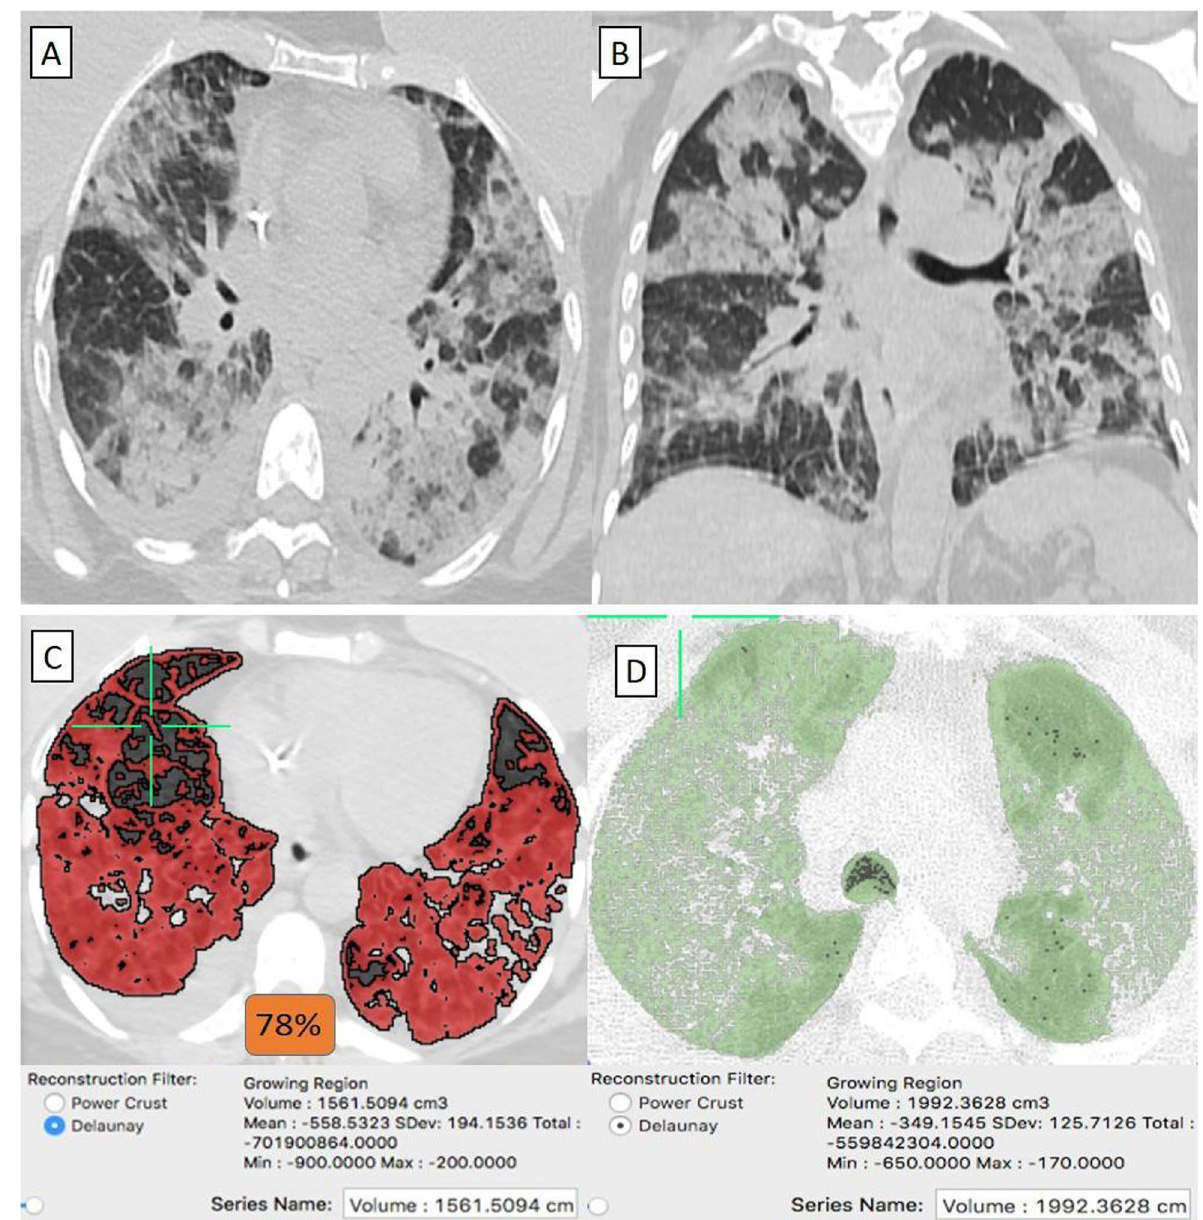
Fig. 10 A 53‑year‑old female patient with history of operated bilateral breast cancer and had received “Sinopharm” vaccine then got COVID‑19 infection. A Axial, and B Coronal chest CT cuts (lung window) showed bilateral wide spread large heterogeneous ground‑glass patches with consolidative changes and minimal right pleural collection. Breast implants are also noticed in axial cuts. C CT‑Volumetry of the pathological lung parts averages 1561 cc. D CT‑Volumetry of total lung volume averages 1992 cc. So, 78% of the lung parenchyma was diseased (Score